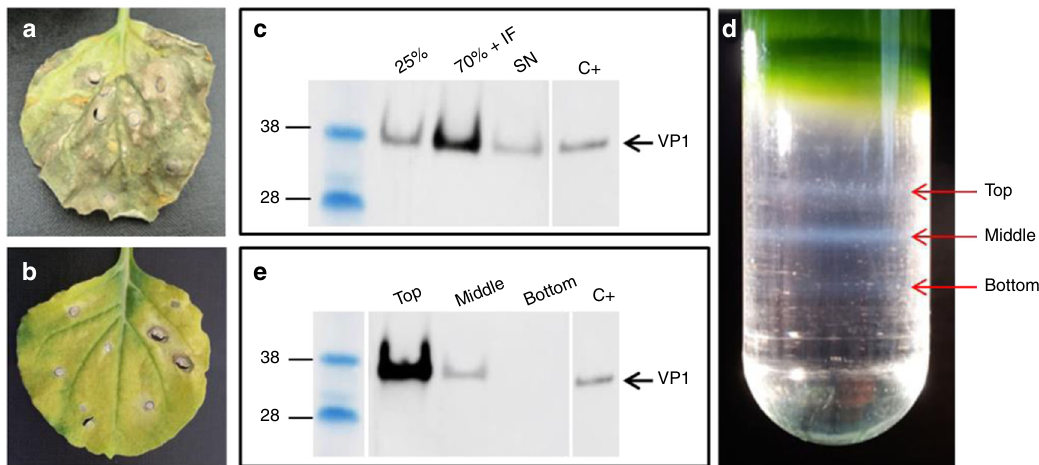
Fig. 1 Production of PV3 VLPs in plants. a N. benthamiana leaf 6 days after in fi ltration expressing PV sVLPs suffering severe necrosis from the high levels of 3CD. b In fi ltrated N. benthamiana leaf 6 days after in fi ltration expressing PV sVLPs using the downregulated 3CD. c Western blot analysis of sucrose cushioned sample showing the strongest signal for VP1 in the 70% sucrose interface (IF). d Nycodenz gradient demonstrating the separation of the PV3 SktSC8 VLPs (top band) from contamination. e Western blot of Nycodenz gradient con fi rming that the top gray band contains most VP1. The lanes with the pre-stained size markers and the positive control (C+) have been duplicated in c and e as all the samples were originally analyzed on the same gel (Supplementary Fig.